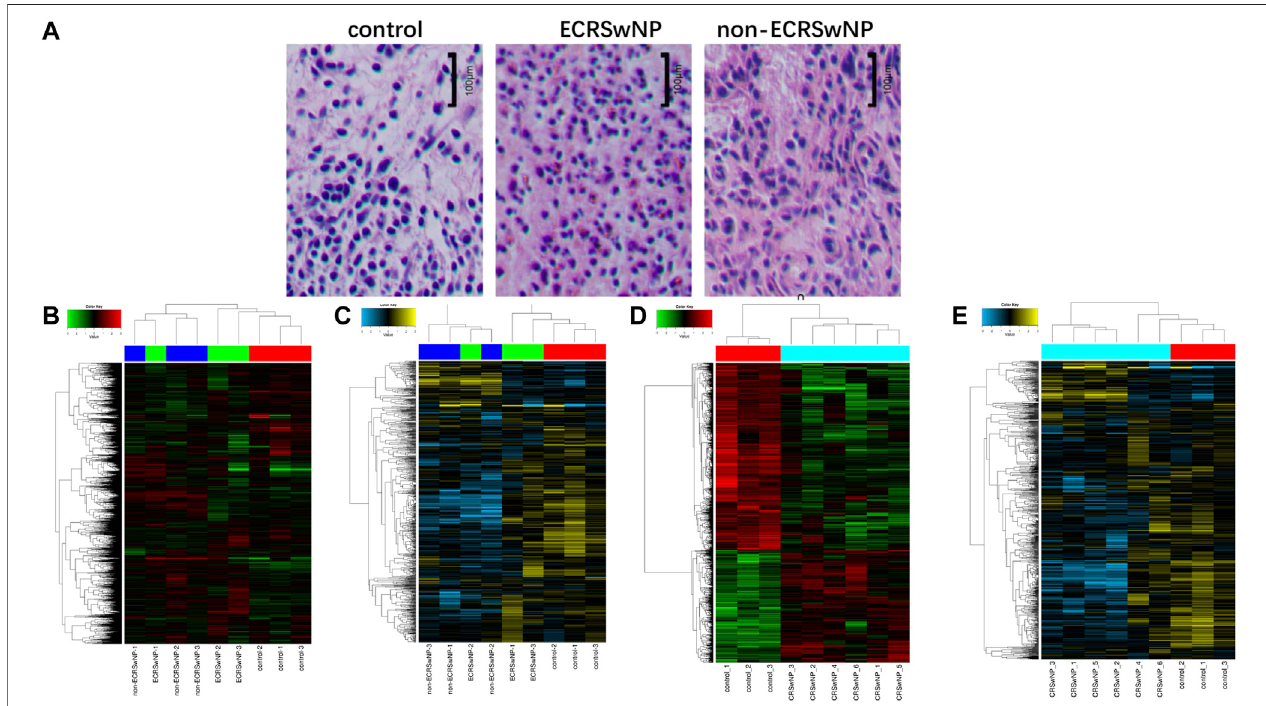
FIGURE 1 | Hematoxylin-eosin staining of control, ECRSwNP, and non-ECRSwNP groups, and differential expression of circRNAs and miRNAs in the three groups. (A) Representative images of hematoxylin-eosin staining. The scale bar represents 100 μ m. (B) Hierarchical clustering analysis heat map showing signi fi cantly changed of circRNAs and (C) of miRNAs with fold change ≥ 2.0 ( p < 0.05) in the three groups (ECRSwNP, non-ECRSwNP, and control). The expressions of circRNAs andmiRNAsweresigni fi cantlydifferentbetweenCRSwNPandcontrolgroups,butECRSwNPandnon-ECRSwNPgroupssharedsimilargeneexpressionpro fi les. Then, they were combined as the CRSwNP group. Hierarchical clustering analysis heat map showing signi fi cantly changed of circRNAs (D) and of miRNAs (E) with fold change ≥ 2.0 ( p < 0.05) in the two groups (CRSwNP and